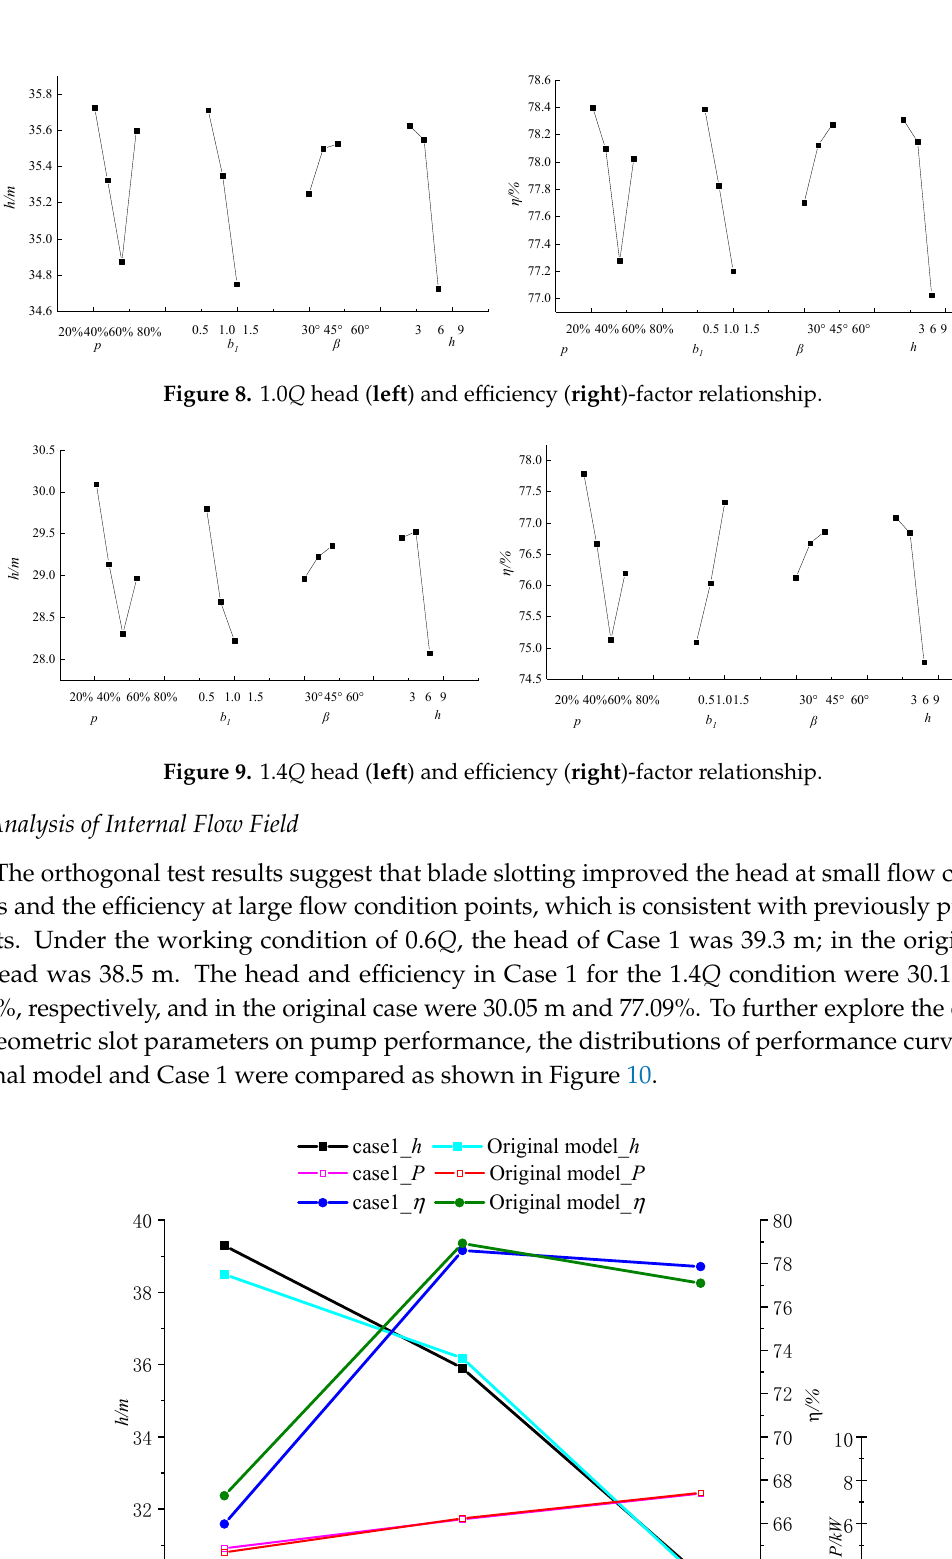
h 963 Figure 7. 0.6 Q head ( left ) and efficiency ( right )-factor relationship.